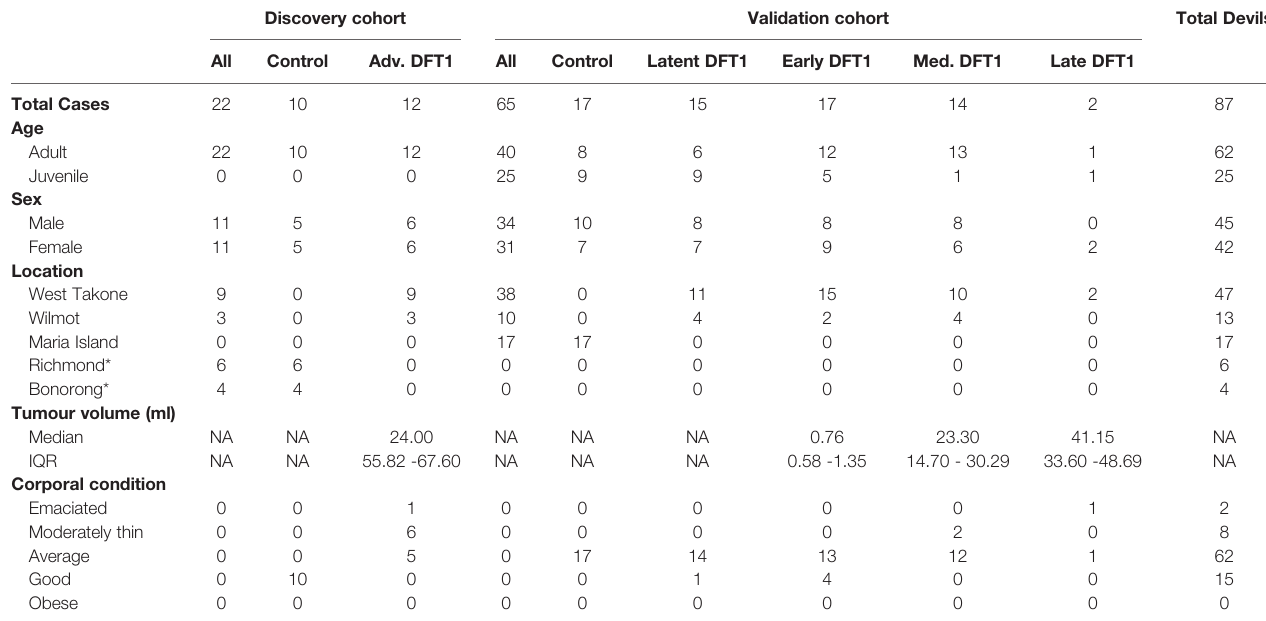
TABLE 1 | Summary of Tasmanian devil cohorts used in this